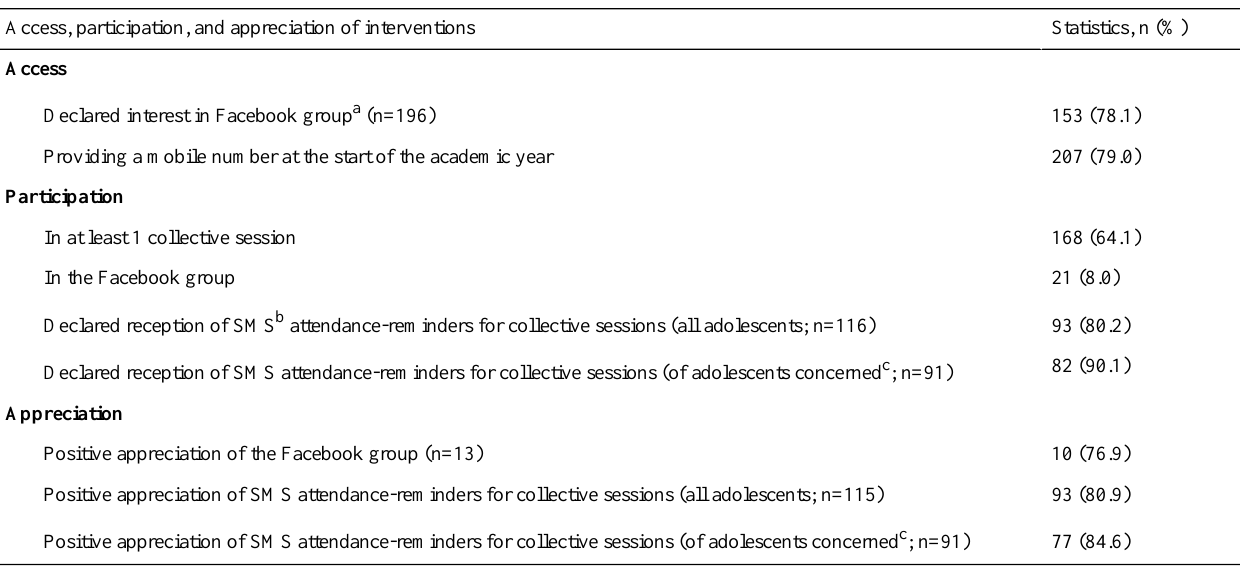
Table 2. Access, participation and appreciation of information and communication technology (ICT) interventions (N=262).